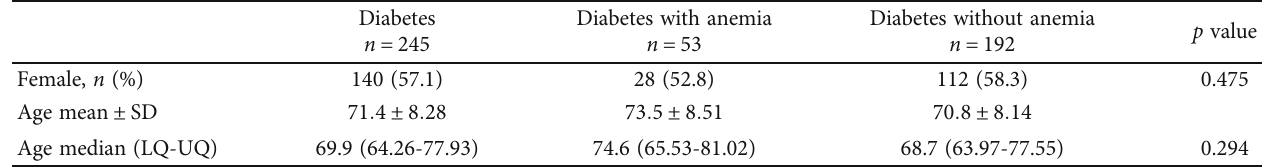
Table 1: Characteristics of the diabetic group.